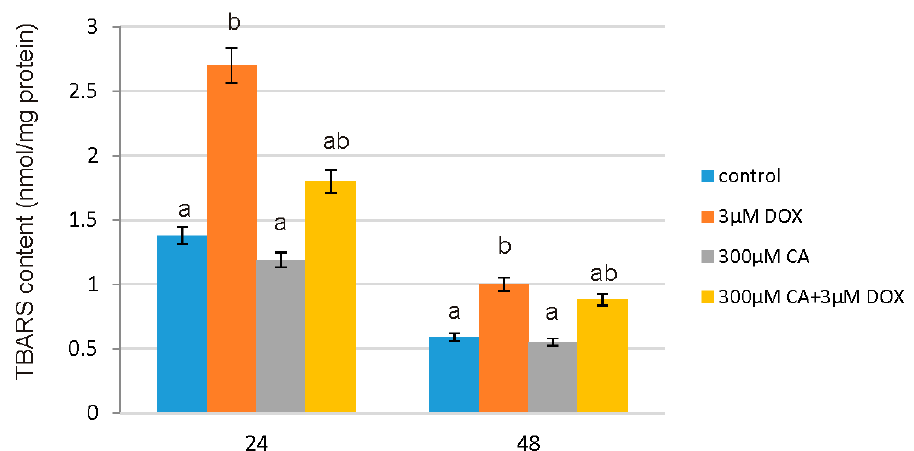
Figure 7. The effect of DOX, CA and CA + DOX on TBARS content in fibroblast cells. The cells were incubated with 3 µ M DOX, 300 µ M CA and DOX (3 µ M) combined with CA (300 µ M) for 24 h and 48 h Mean values from three independent experiments ± SD are shown. Different letters (a, b) indicate statistical differences ( p ≤ 0.05) between control, 3 µ M DOX, 300 µ M CA and DOX combined with CA estimated by Tukey’s test.